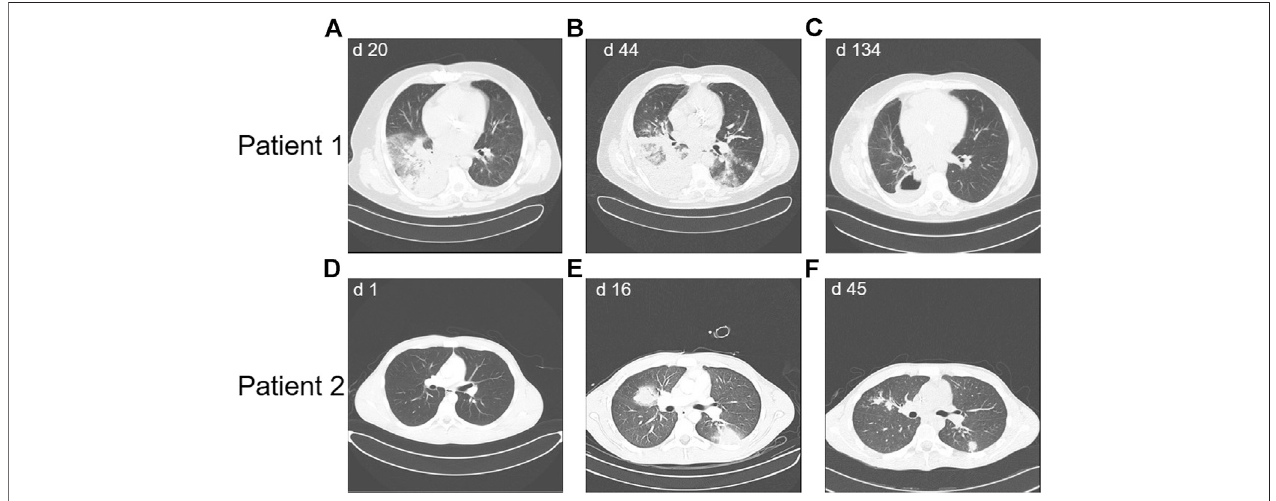
FIGURE 2 | Thoracic CT scans showing the course of mycotic lesions in Patient 1 (panels A-C) and patient 2 (panels D-F) , d (cid:1) day after diagnosis of ALL.